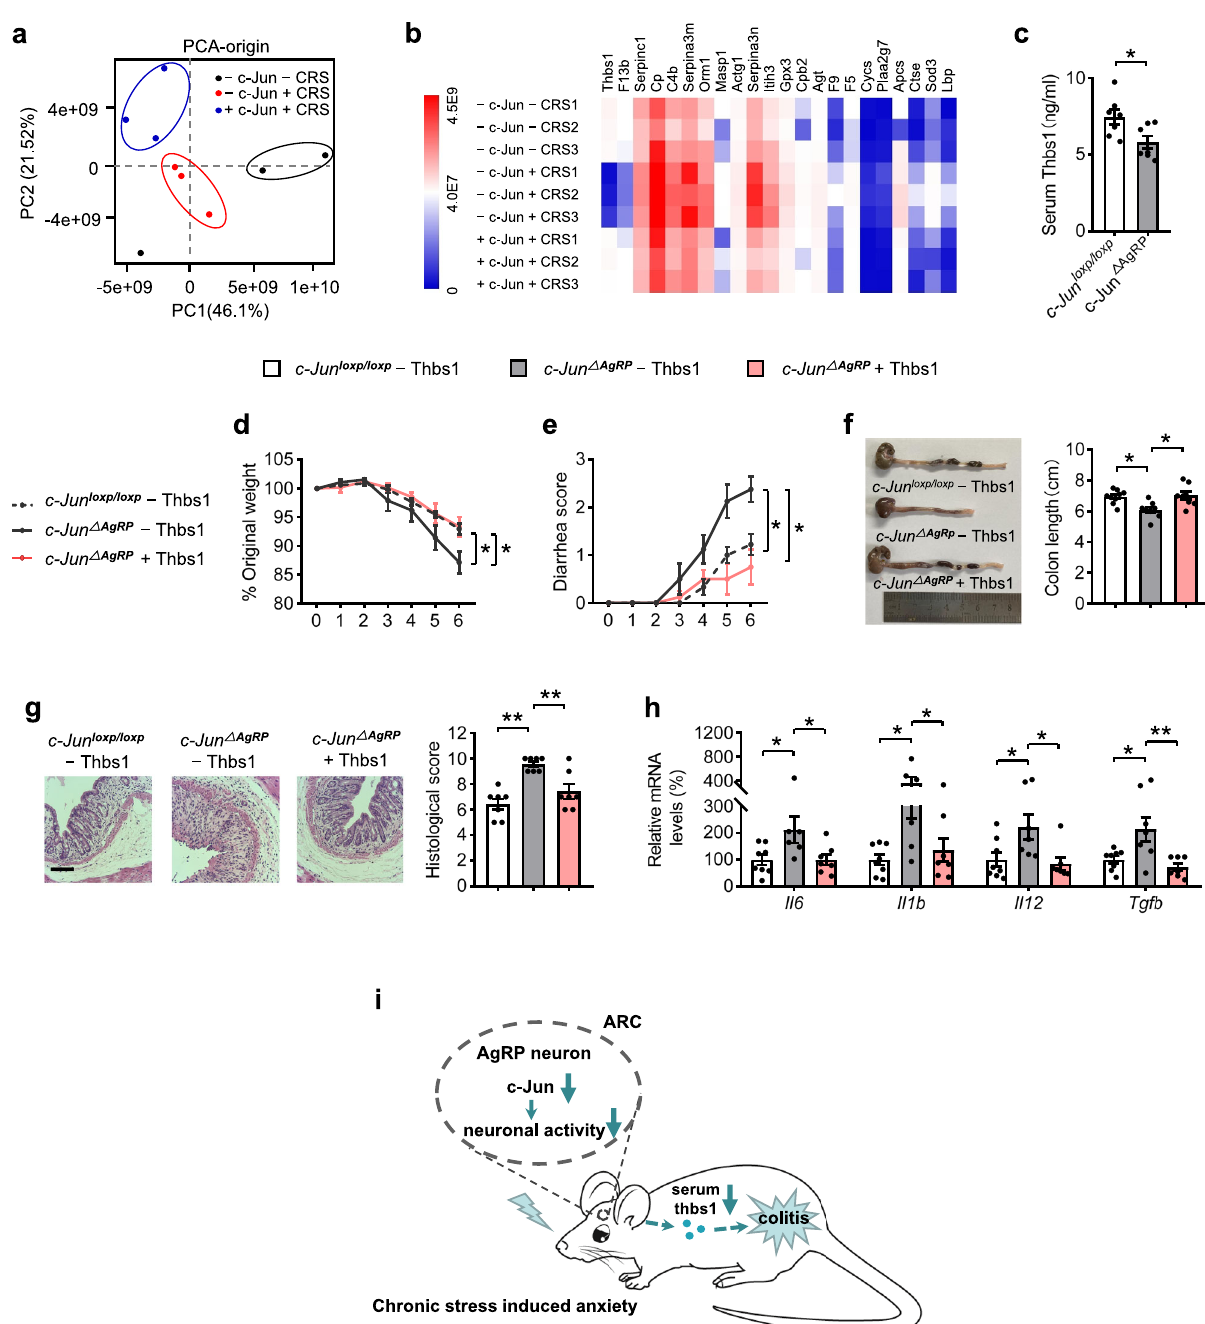
Fig. 4 The increased colitis susceptibility in c-Jun Δ AgRP mice is mediated by THBS1. a Partial least-squares discriminant analysis of protein composition. b Spearman ’ s correlation analysis of serum proteome. c Serum THBS1 levels. d Percentage of body weight loss. e Scores of diarrhea. f Gross morphology and length of the colon. g H&E staining and histological scores of the colon tissues. Scale bar, 110 μ m. h qRT-PCR analysis of mRNA expression of in fl ammatory cytokines ( Il6, Il1b, Il12 , and Tgfb ) in the distal colonic tissues. i Summary Diagram. Chronic restraint stress induces anxiety-like behaviors and colitis susceptibility, which is mediated by c-Jun in AgRP neurons. Knockdown of c-Jun in AgRP neurons increases colitis susceptibility through reducing serum THBS1 levels. Studies for a , b were conducted using - c-Jun - CRS mice, - c-Jun + CRS mice and + c-Jun + CRS mice with 3% DSS for 7 days. Serum was collected after DSS stimulation for proteomics pro fi ling. c was conducted using 24 – 26-week-old c-Jun loxp/loxp mice and c-Jun Δ AgRP mice with DSS administration. d – h were conducted using 22 – 24-week-old c-Jun loxp/loxp mice and c-Jun Δ AgRP mice with ( + thbs1) or without (- thbs1) THBS1 supplementary, simultaneously receiving 3% DSS treatment for 6 days to induce acute colitis. Values are expressed as means ± SEM ( n = 3 – 9 per group), with individual data points. Data were analyzed using two-tailed unpaired Student ’ s t -test ( c ). Data were analyzed using two-way analysis of variance, followed by Tukey ’ s multiple comparisons test ( d , e ). Data were analyzed using one-way analysis of variance, followed by Tukey ’ s multiple comparisons test ( f – h ). * P < 0.05, ** P <